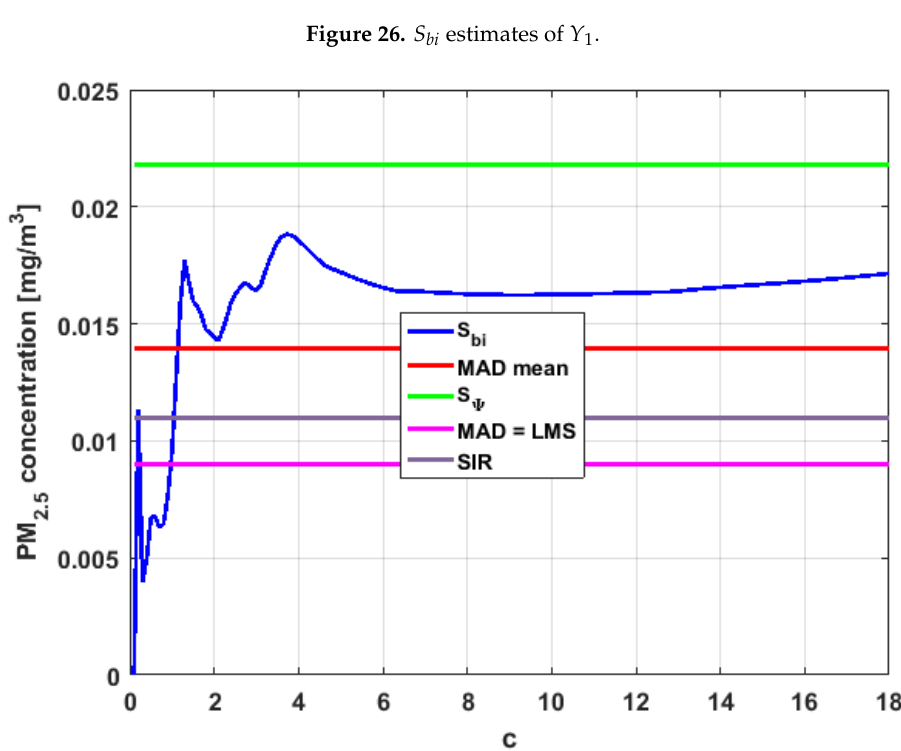
Figure 27. S bi estimates of Y 2 Figure 27. 𝑆 𝑏𝑖 estimates of 𝑌 2 . Figure 27. 𝑆 𝑏𝑖 estimates of 𝑌 2 .